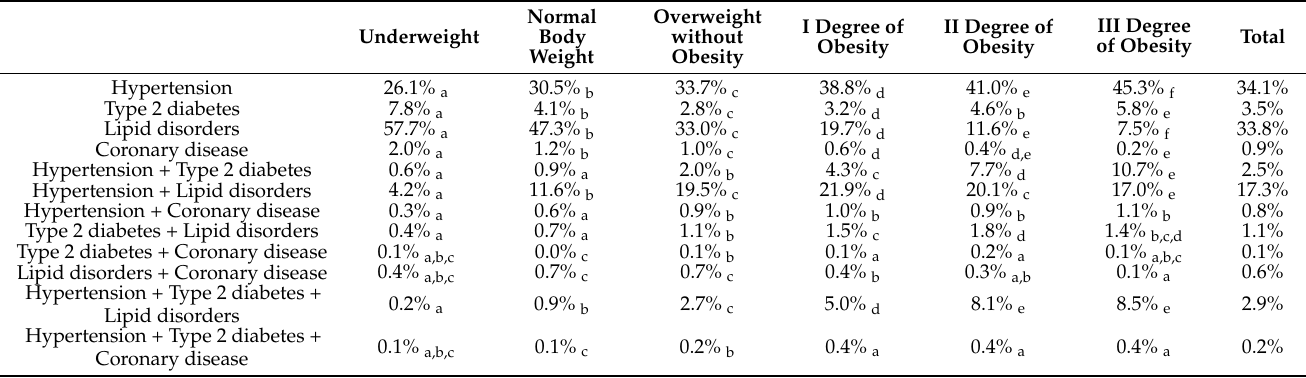
Table 8. Relationship between BMI and comorbidities; data presented as percentage of BMI 1